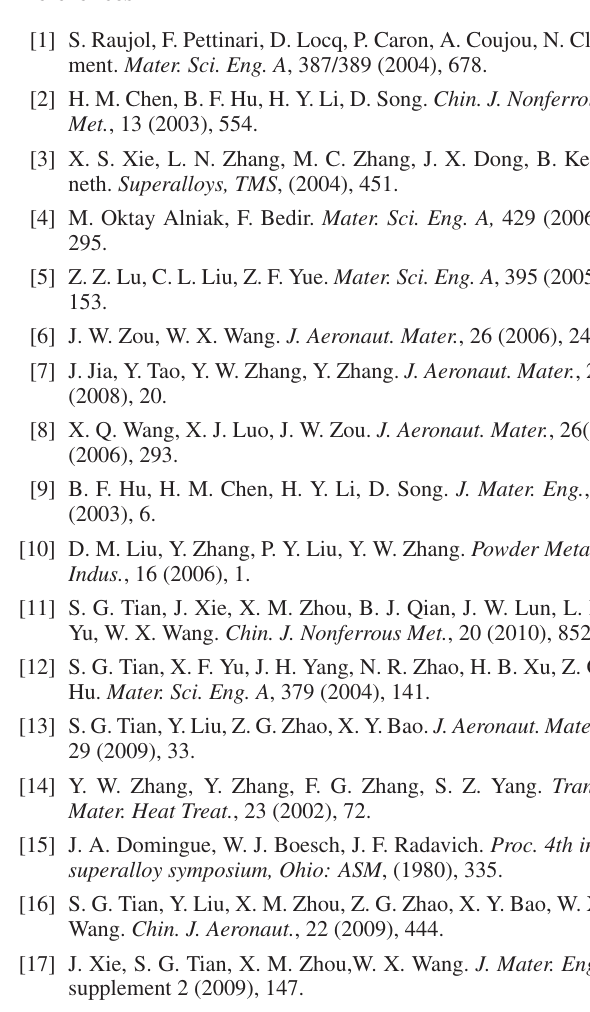
Figure 6. After HIP treated at 1180 ı C and fully heat treated, microstructure of the alloy crept up to fracture at 1034 MPa/ 650 ı C. (a) Deformed dislocations shearing into (cid:2) 0 phase marked by shorter arrow, and stacking fault marked by longer arrow, (b) the dislocations tangled along the upright-like direction, and the stacking fault appeared along the hor- izontal direction as marked by arrows, respectively (c) the carbide particle precipitates in the alloy as marked with ar- rows, and the deformed dislocations piled up in the region near the carbide as marked by letters A and B. ferent orientations, which can hinder the dislocation move- ment to enhance the creep